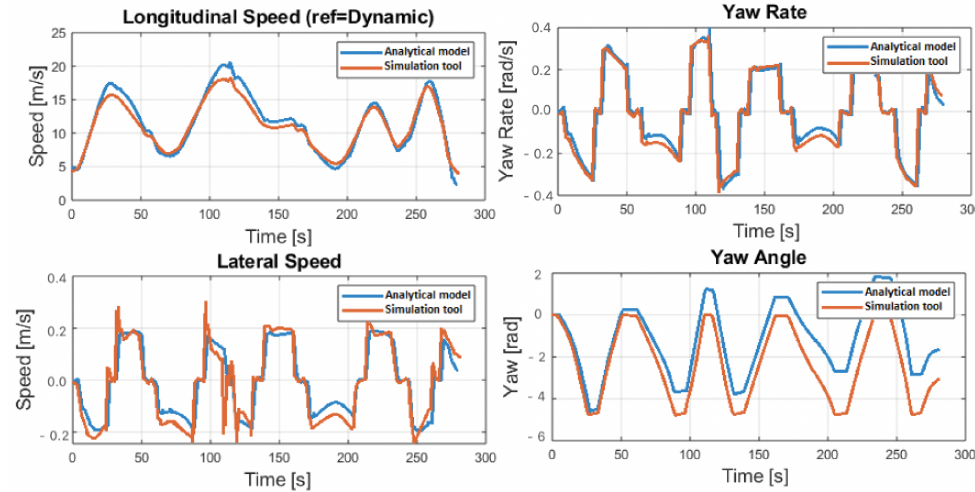
Figure 21. Dynamic speed results after sensitivity